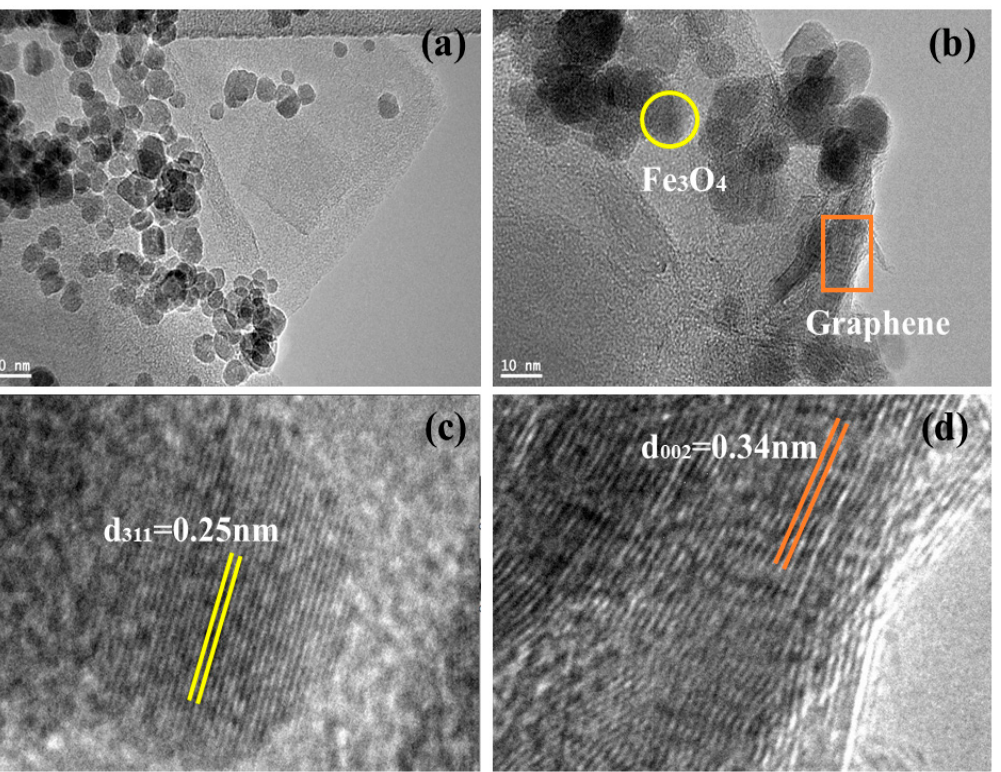
Figure 3. ( a ) TEM image of Fe 3 O 4 /Gr nanocomposite, ( b – d ) HRTEM images of nanocomposites showing Fe 3 O 4 nanoparticles presented in circle shape (yellow color) corresponding to (311) plane with 0.25 nm interplanar lattice spacing ( c ) and rectangular shape shows the graphene (orange color) corresponds to (002) plane with 0.34 nm interplanar lattice spacing, presented in ( d